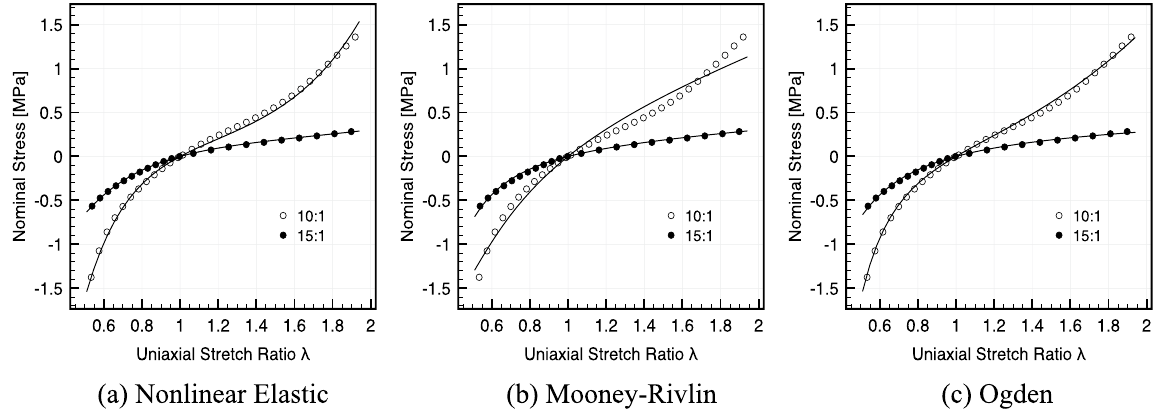
Figure 6. Tuning of material models. Fitting of experimental stress vs. stretch ratio curves for 10:1 v/v (empty circles) and 15:1 v/v (filled circles) PDMS using different material models: ( a ) nonlinear elastic (Eq.(7)); ( b ) hyperelastic Mooney-Rivlin (Eq. (8)); ( c ) hyperelastic Ogden (Eq. (9)). Tensile and compressive tracts are shown up to 100% and 25% strain,